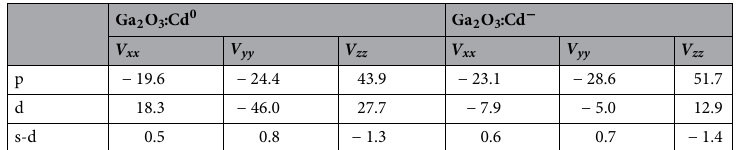
Table 2. p , d and s - d valence contributions to the EFG tensor in the principal components axes (in units of V/ 2 Å ) for each Cd charge state (by definition, | V zz | ≥